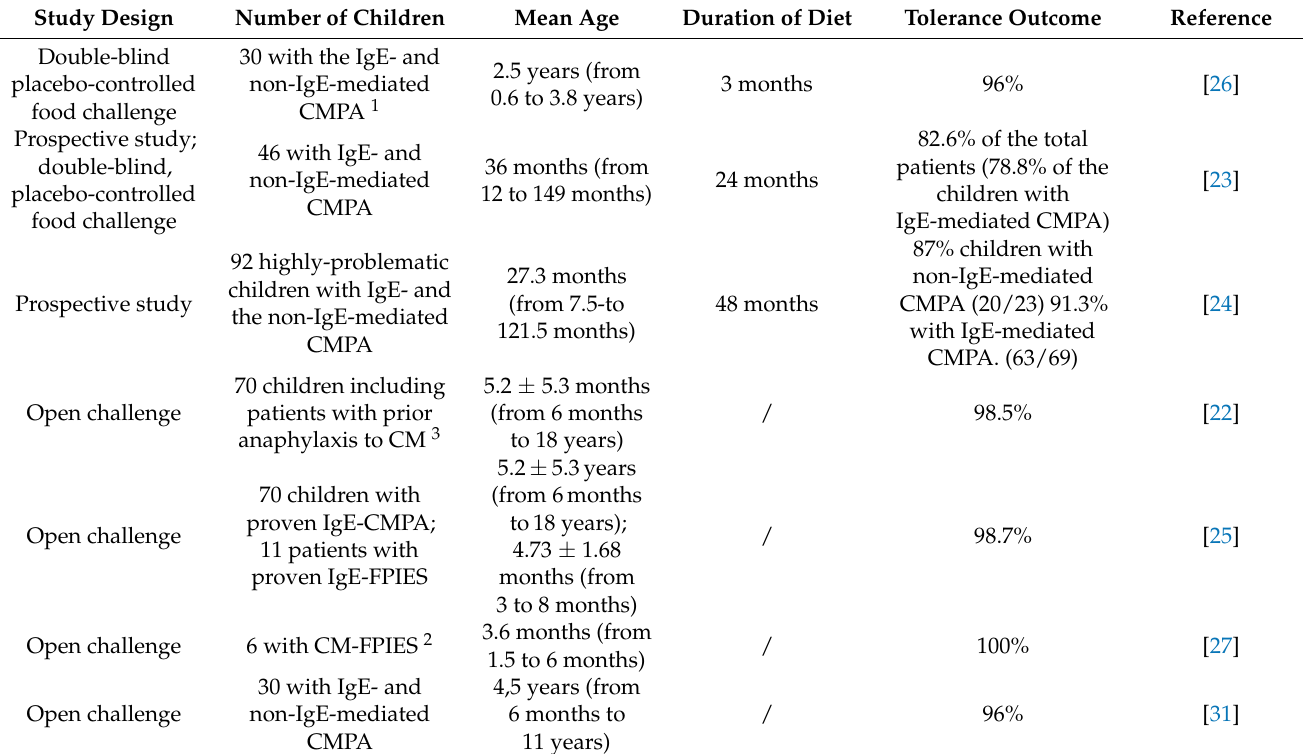
Table 1. Studies on the tolerability of donkey milk in